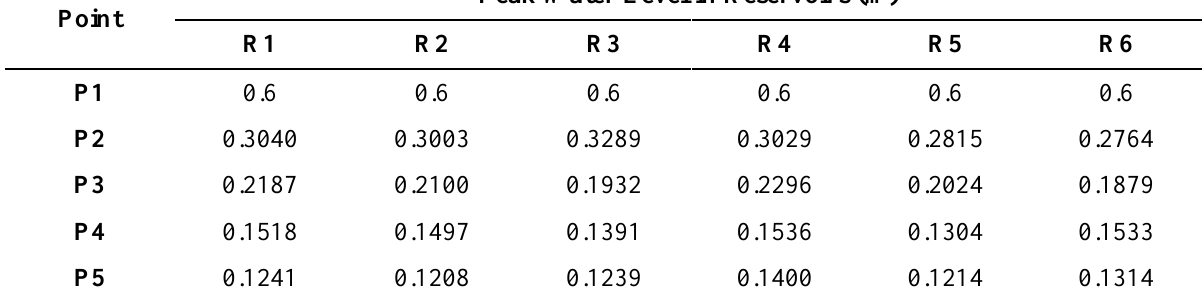
Peak water levels.